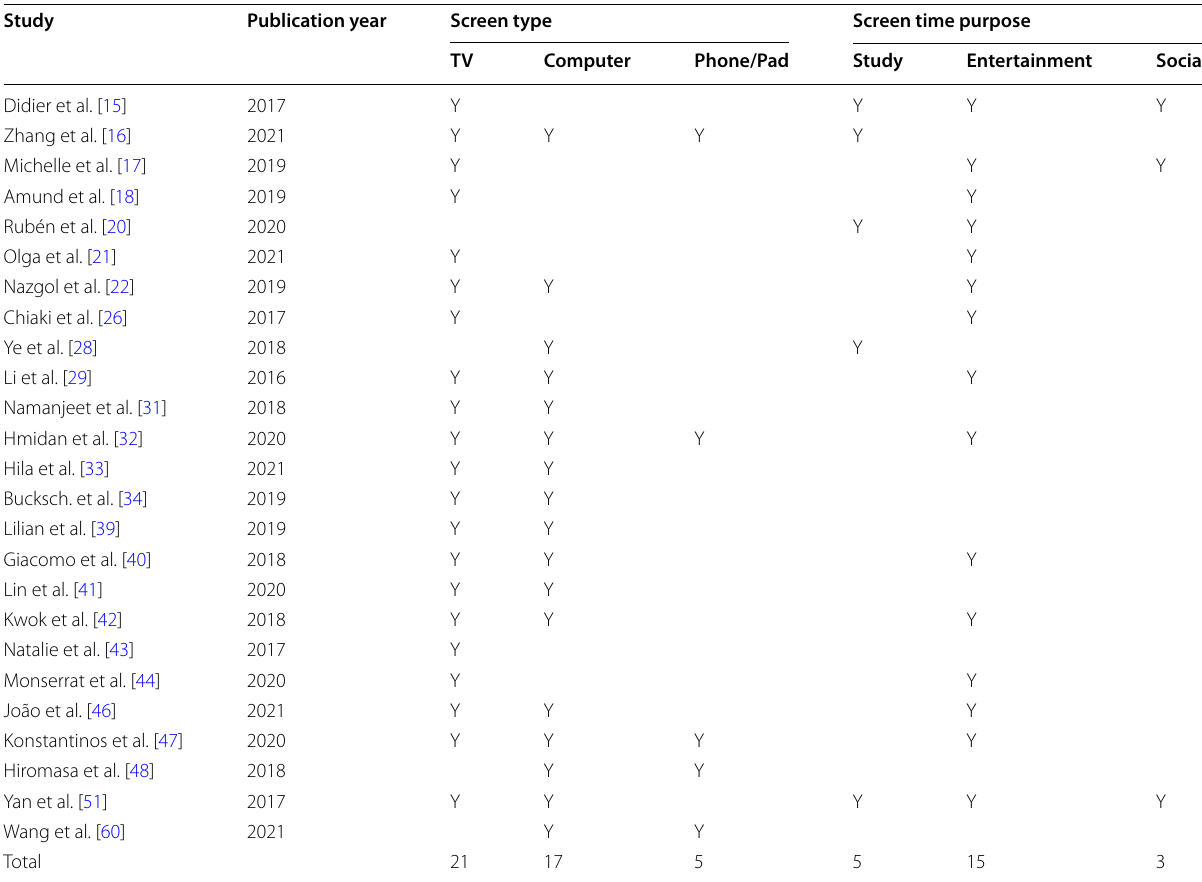
Table 2 Main uses of school-age children’s screen